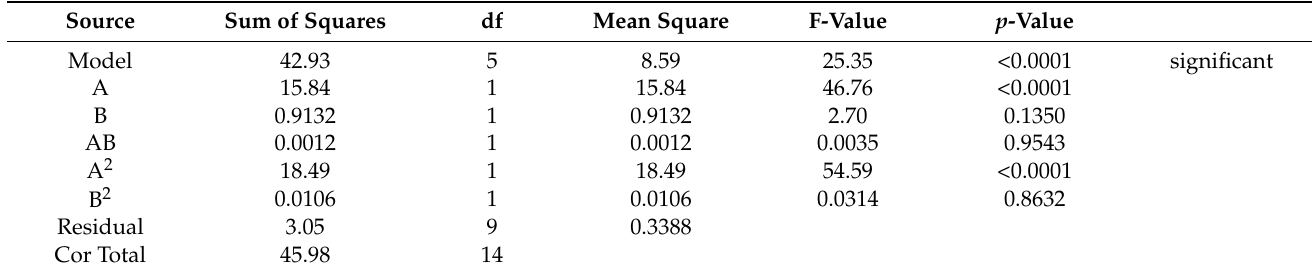
Table 3. ANOVA table for third output response (SDWP).